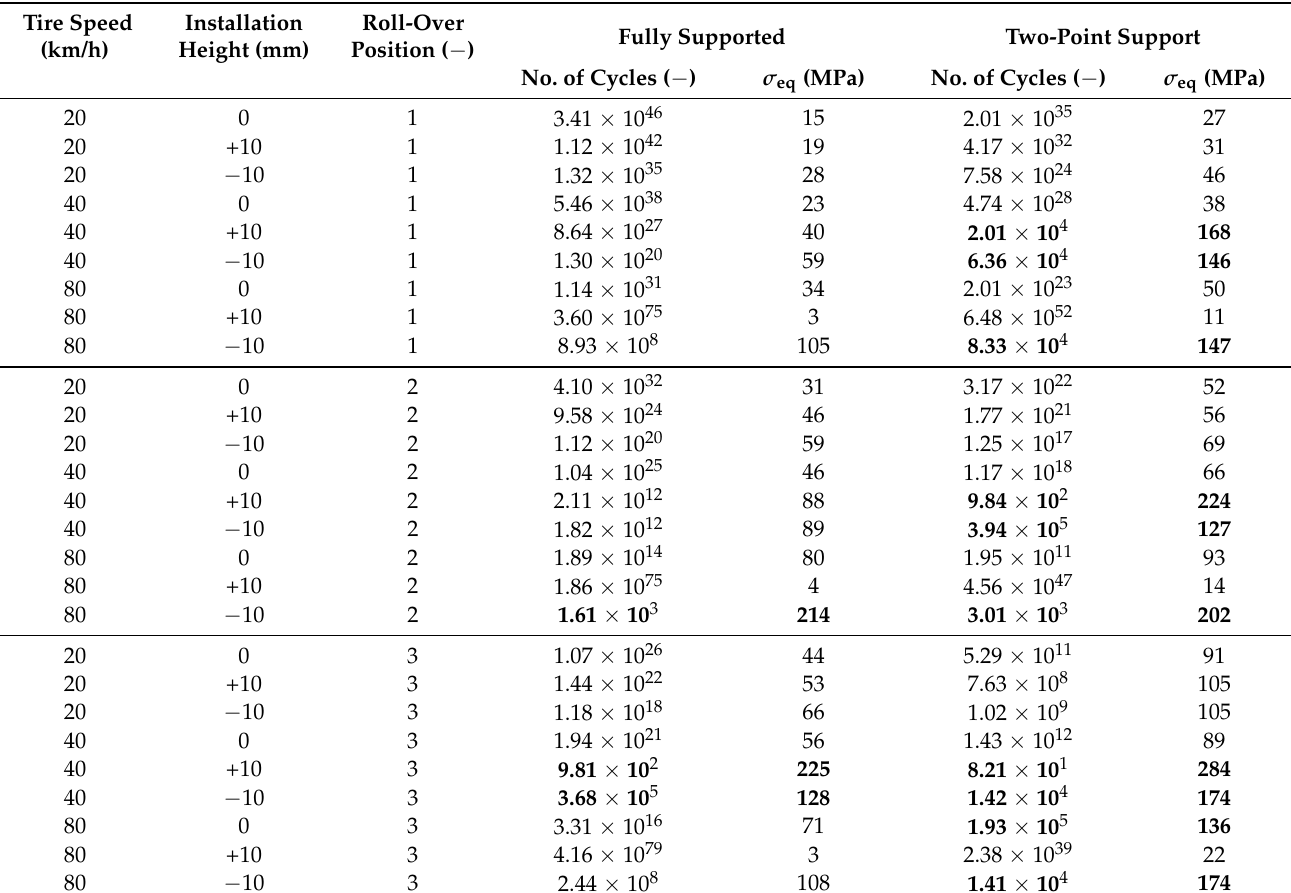
Figure 3. Simulation results. ( a ) Load scenario with a speed of 40 km/h, bulged position, tire roll-over on two-thirds of the cover radius, and two-point support; ( b ) load scenario with a speed of 40 km/h, bulged position, tire roll-over on two-thirds of the cover radius, and full support. Critical locations are marked as Control Points 1 and 2. Table 3. The results of 54 scenarios with different boundary conditions for Critical Location 2. Tire roll-over position 1—centre of the cover; Position 2—offset from the centre by a third of the cover radius; Position 3—offset from the centre by two thirds of the cover radius (Figure